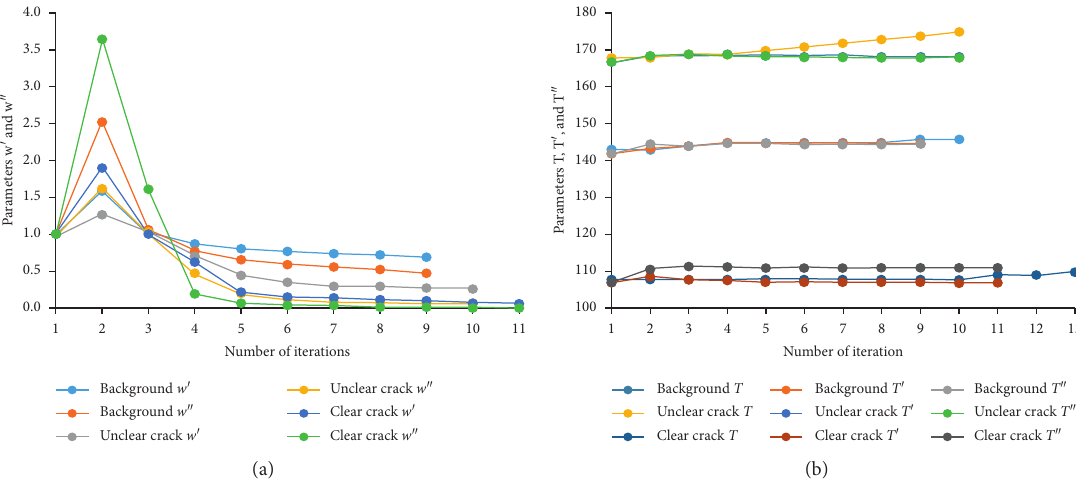
Figure 28: The effectiveness of the slacken stride strategies: (a) alteration of the stride parameter; (b) alteration of the threshold